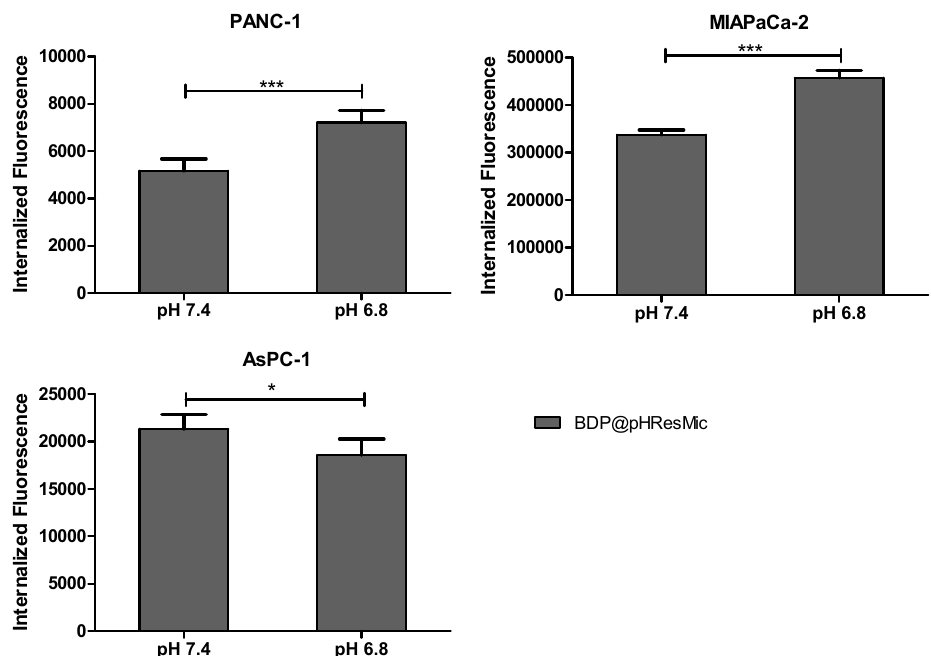
Figure 7. Histogram plots showing the results of uptake studies of pHResMic on 2D model of PDAC cells. The histograms report the amounts of internalized BDP@pHResMic, expressed as the difference between mean fluorescence at 37 °C and at 4 °C registered values, obtained after 1 h incubation of cells with micelles at pH 7.4 or pH 6.8. Histogram bars represent the mean ± SD of three independent experiments. (* p < 0.05, *** p < 0.001).